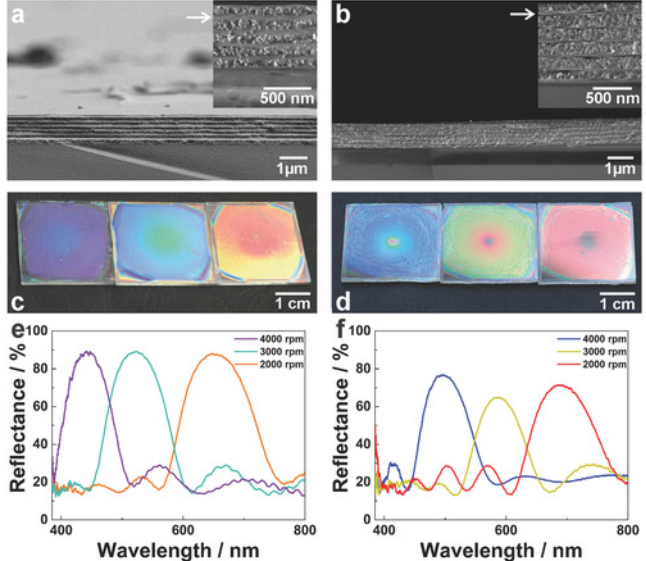
Figure 5. Touchless control system. ( a ) SEM cross-section images of the SiO 2 /H 3 Sb 3 P 2 O 14 film fabricated by 4000 rpm spin-coating speed. ( b ) SEM cross-section images of the TiO 2 /H 3 Sb 3 P 2 O 14 film fabricated at the same spin-coating speed. ( c ) Photographs of the SiO2/H3Sb3P2O14 Bragg stacks produced at different spin-coating speeds, from left to right: 2000, 3000, and 4000 rpm, respectively. ( d ) Photographs of the TiO 2 /H 3 Sb 3 P 2 O 14 BSs produced at the same spin-coating speeds. ( e ) Spectra of the SiO 2 /H 3 Sb 3 P 2 O 14 films shown in ( c ). ( f ) Spectra of the TiO 2 /H 3 Sb 3 P 2 O 14 films shown in ( d ). Reprinted with permission from ref. [20]. Copyright 2015 Wiley